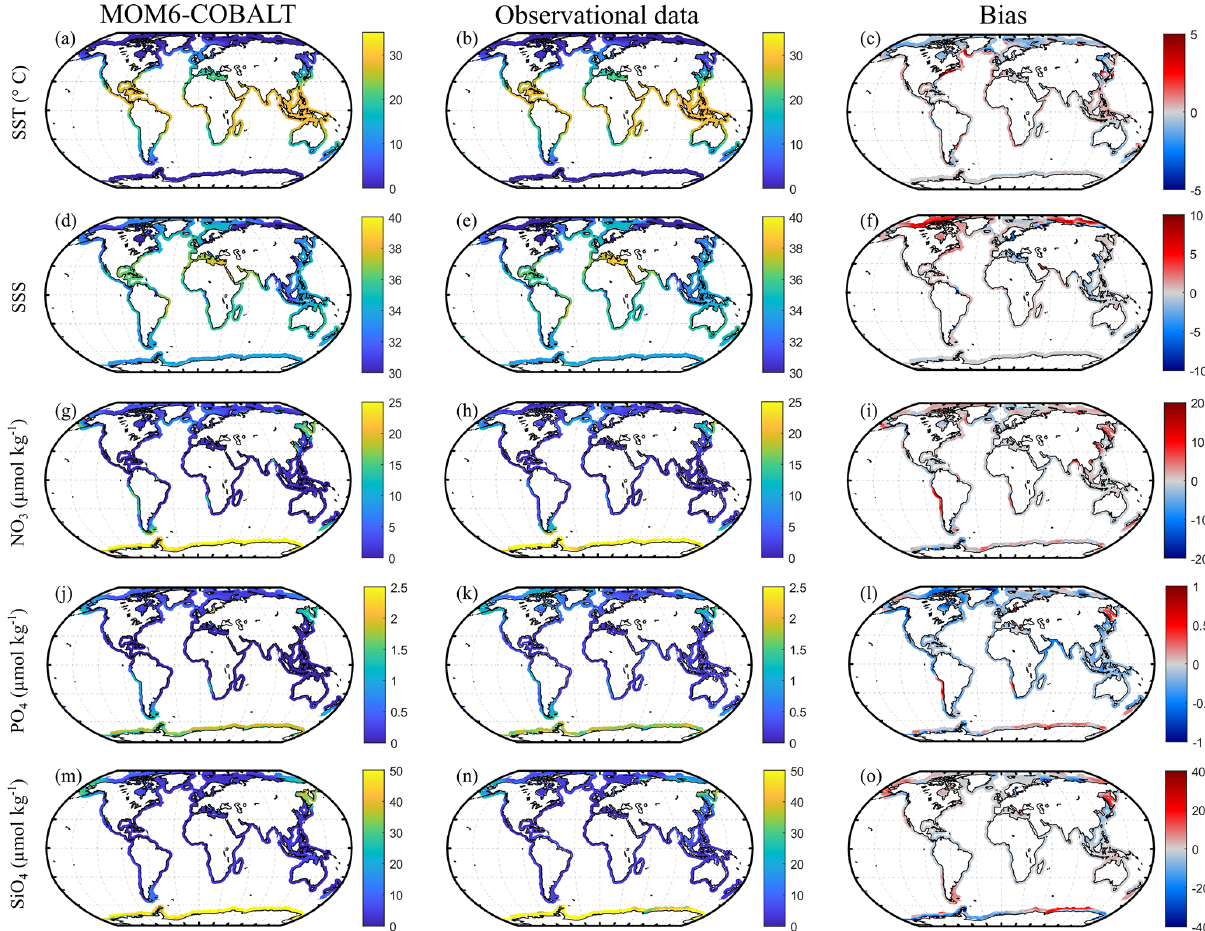
Figure 2. Observed (center) and modeled (left) spatial distributions of the annual mean state of SST ( ◦ C), SSS (no unit), nitrate (NO 3 , µmolkg − 1 ), phosphate (PO 4 , µmolkg − 1 ) and silicate (SiO 4 , µmolkg − 1 ) and model annual mean bias (right). Observational SST and SSS fields are from the NOAA OI SST V2 (Reynolds et al., 2007) and the EN4 SSS (Good et al., 2013). Observational nutrients are from the World Ocean Atlas version 2018 (Garcia et al., 2019). The bias is the difference between MOM6-COBALT and observed values (red indicates regions where the simulated variables by MOM6-COBALT exceed observed